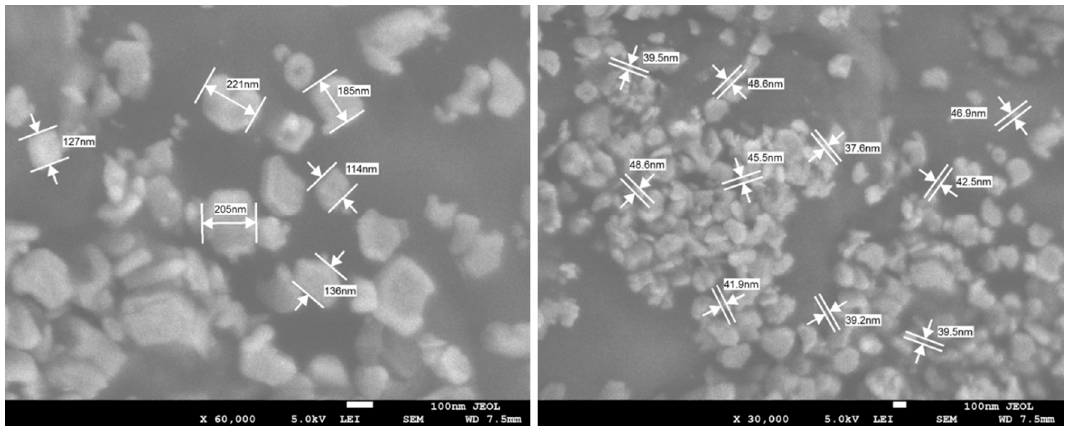
Figure 7. SEM image of gold nanoparticles (AuNPs) in the polymer matrix HLCuCl 0.05 wt% gold chloride 4 wt%, TEA 1wt%, and iodonium salt 1 wt% dissolved in EGDA 93.95 wt%.